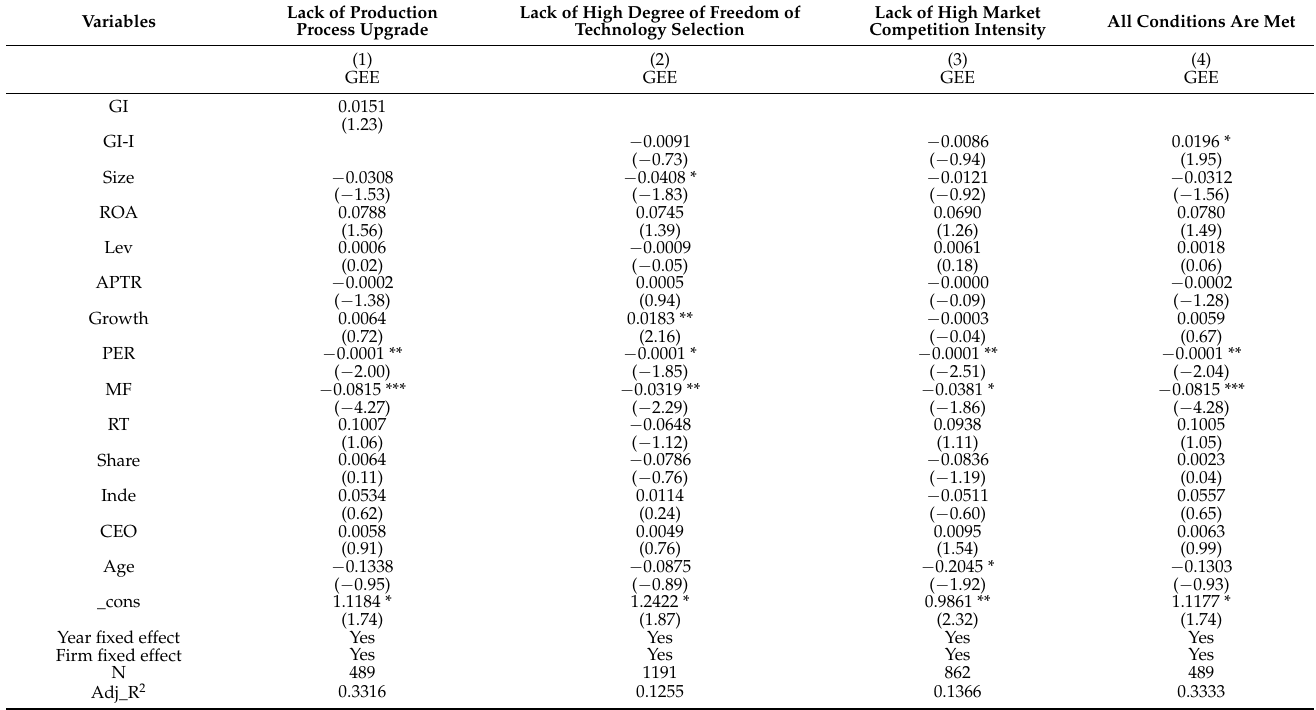
Table A15. The positive impact of green innovation on green economic efficiency (Full version of Table